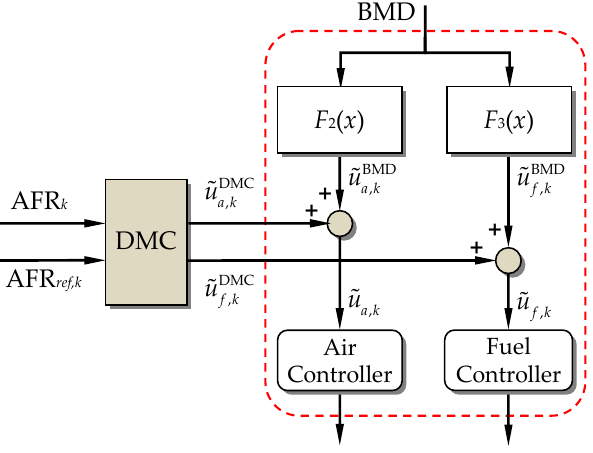
Figure 3. Proposed control system configuration.